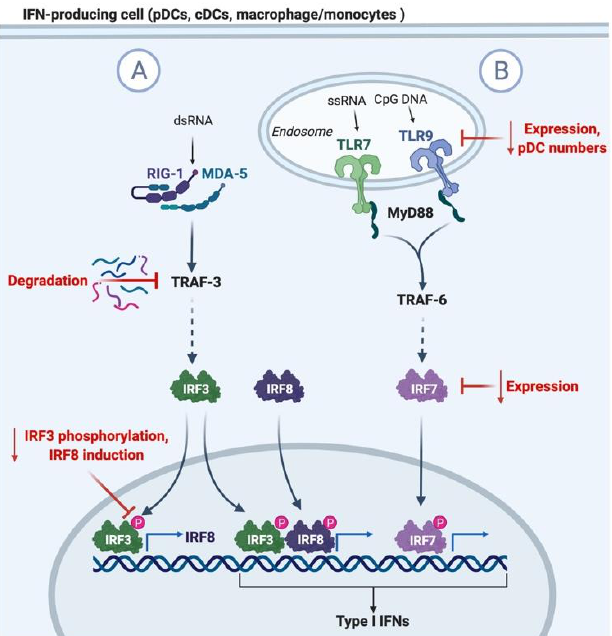
Figure 1. Diagram of type I IFN induction and mechanisms of impaired induction in aging. ( A ) Recognition of viral dsRNA in the cytosol by RIG-1 or MDA-5 leads to IRF3 activation of TRAF-3. Aging is associated with the degradation of TRAF-3 and the reduced phosphorylation of IRF3. IRF3 mediates the transcription of type I IFNs and IRF8, which feedbacks to amplify the expression of type I IFNs. ( B ) TLR7 and 9 recognition of viral ssRNA and CpG DNA in pDCs induces the activation of MyD88 and TRAF6, leading to the activation of IRF5 and 7, and the translocation to the nucleus for the transcription of type I IFNs. Aging leads to the reduction in pDC numbers in circulation, TLR7/9 expression, and IRF7 adaptor expression.